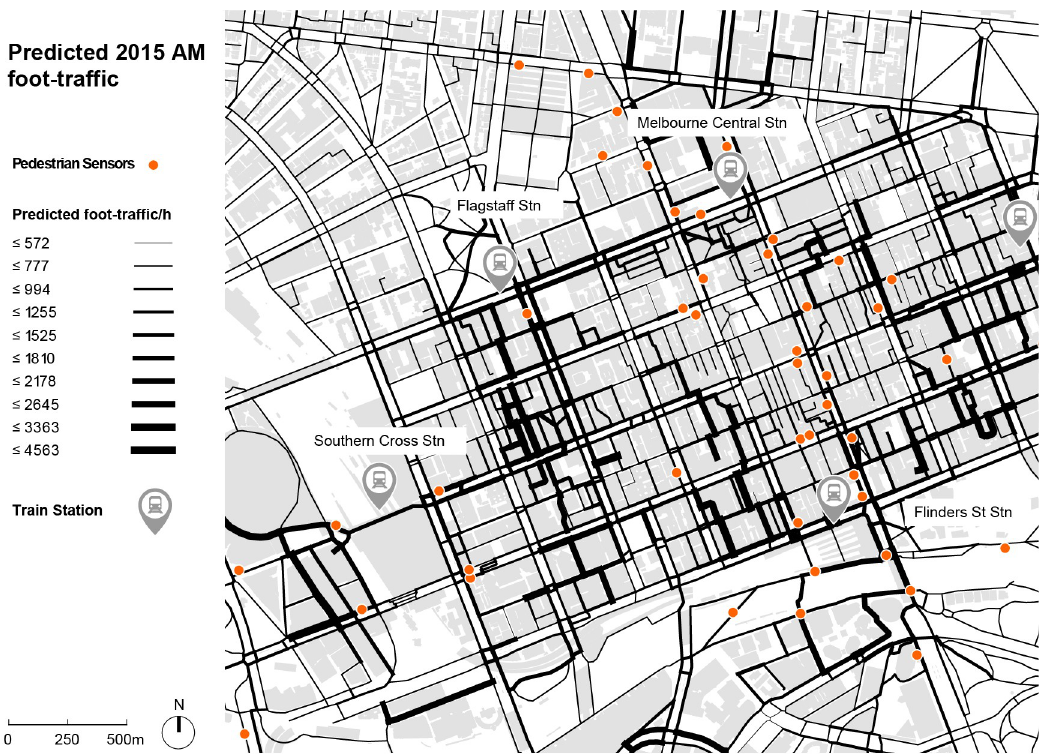
Fig 4. Predicted pedestrian flows during a typical workday AM peak period (8.00–9.00AM) in June 2015, based on June 2014 calibration.